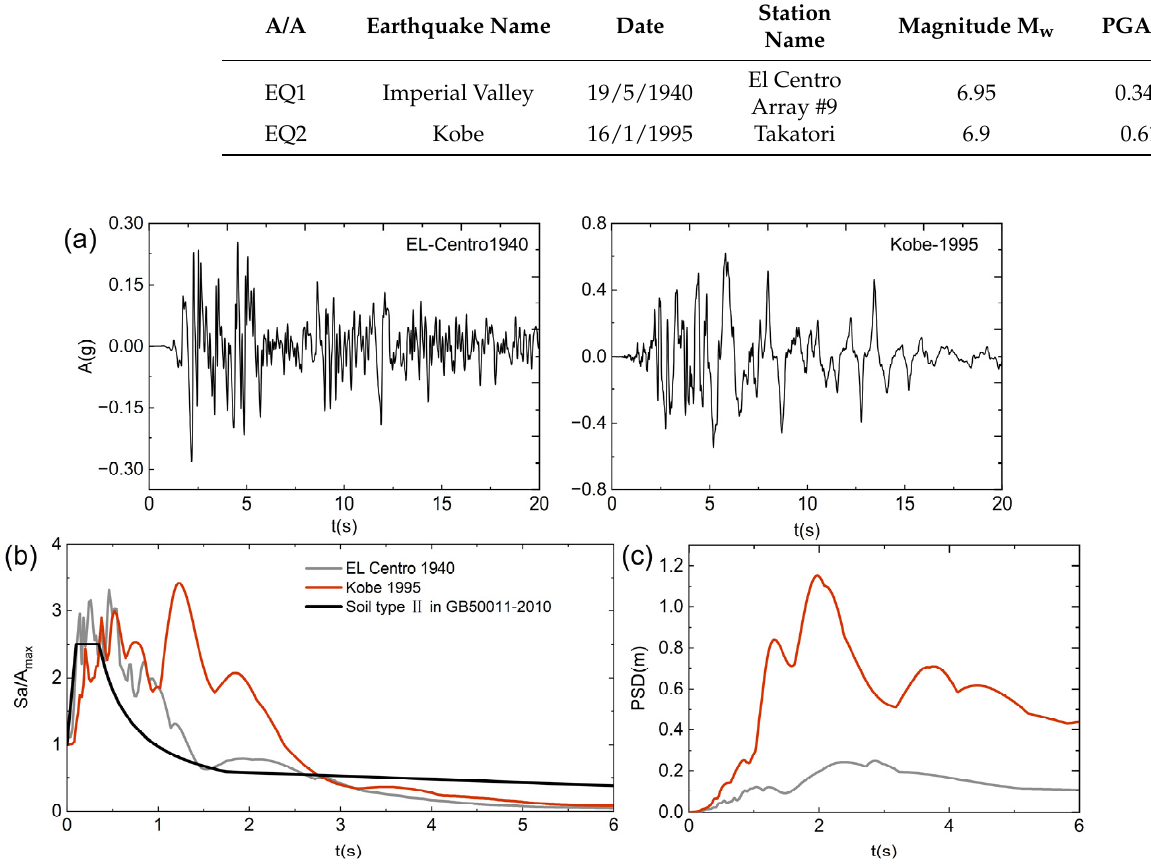
Figure 6. ( a ) Time histories of the input motions (PGA scaled to 0.1 g, 0.2 g, and 0.3 g) ( b ) acceleration response spectra of the input motions and design response spectrum of soil type II in GB50011-2010 ( c ) displacement response spectra of the input motions. Table 7. Input seismic motion.